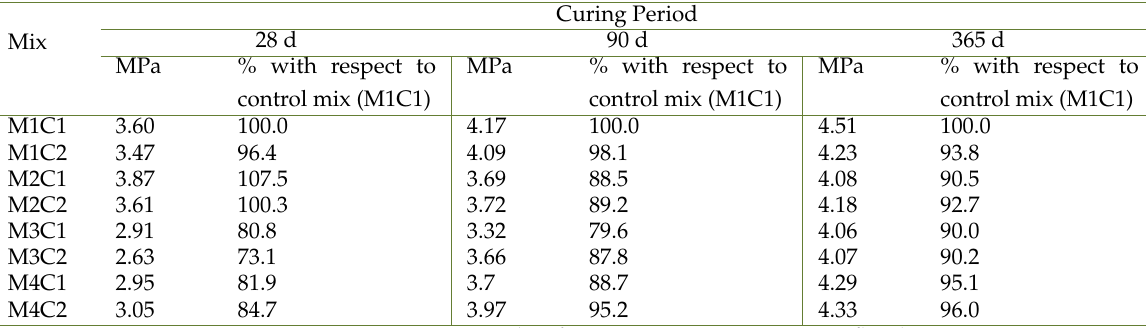
Table 4. Split tensile strength of concrete in MPa